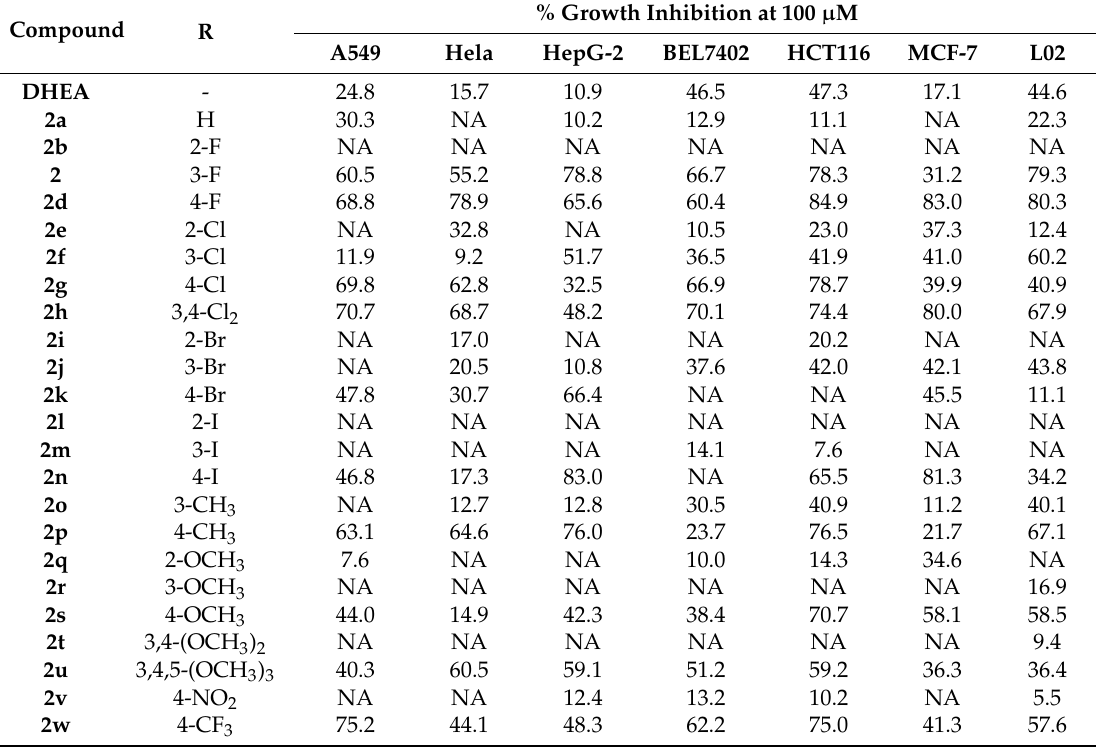
Table 1. The antiproliferative activity of compounds 2a – 2w (% Growth Inhibition at 100 µ M). DHEA: Dehydroepiandrosterone, NA: antiproliferative activity